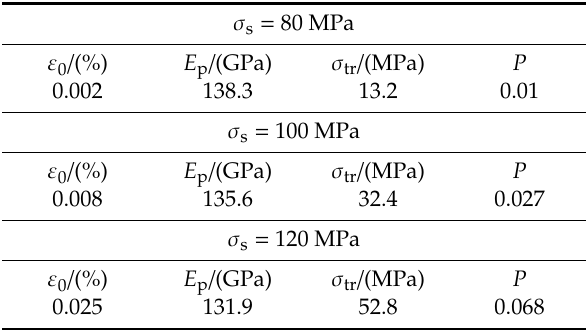
Table 8. The tensile stress–strain curve, tangent modulus, interface debonding fraction and broken fiber fraction of 2D SiC / SiC composite subjected to stochastic loading of σ s = 80, 100 and 120